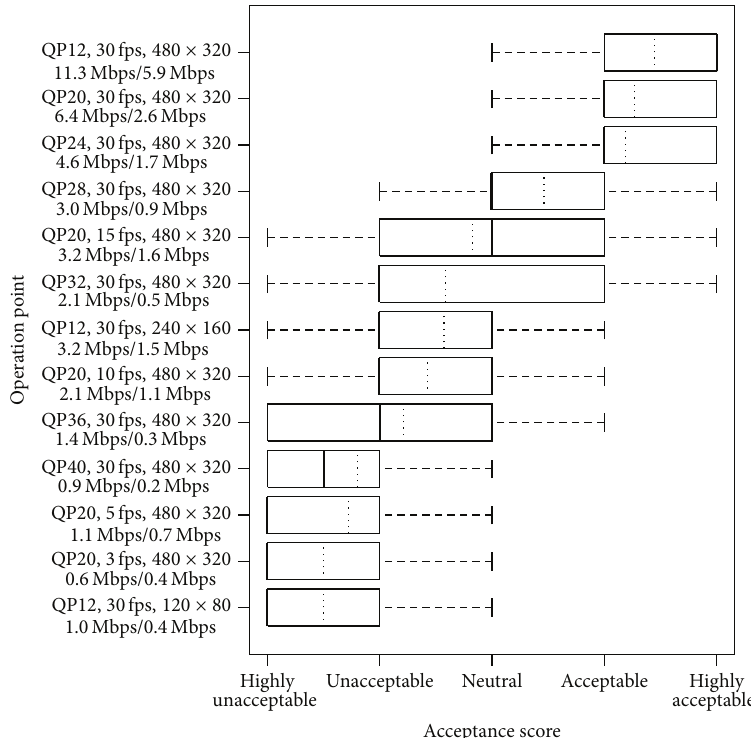
Figure 12: Box plot of acceptance scores for compression, resolution, and frame rate adaptations. The central box spans the interquartile range, with minimum and maximum scores illustrated by “whiskers” to the left and right. Within the box, the bold line corresponds to the median, whereas the dotted line represents the mean acceptance score. The resulting bitrates are also included for each step. The first bitrate is when using I-frames only, which is used in the subjective assessments in order to maintain focus on the given quality parameters and avoid irrelevant artifacts. A real-world scenario would include interframe coding (like IBB ∗ used in the second bitrate) giving a lower rate (we did not observe any visual difference between the I ∗ and IBB ∗ videos); these rates are comparable to the rates observed in the Comoyo analysis given in Section 3.